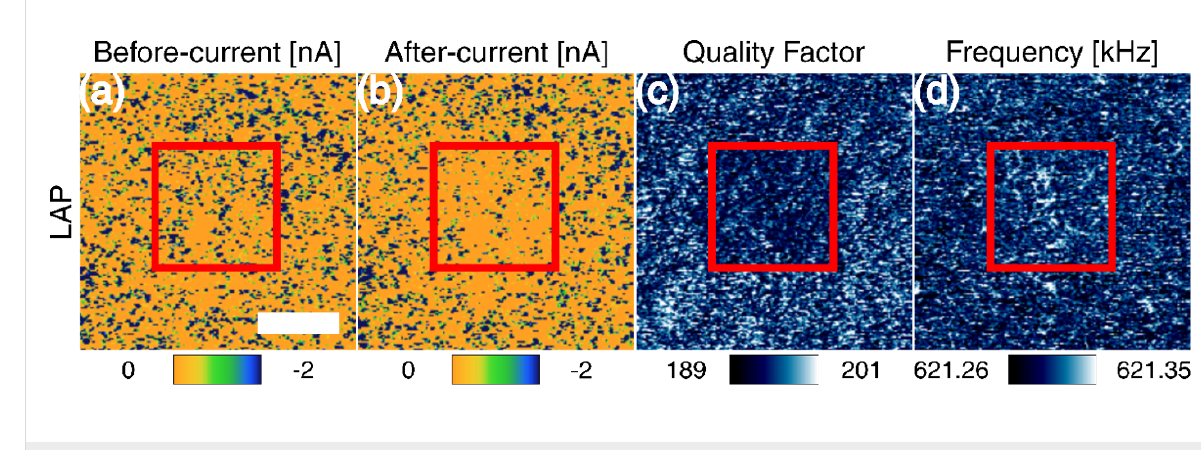
Figure 8: Electro-mechanical response of the transparent (thin) Laponite RD nanocomposite to the high-pressure treatment. Sequential imaging is used to acquire (a) current before the bimodal AFM treatment, (b) current after the treatment and, finally, (c,d) mechanical parameters after the treat- ment ((c) quality factor and (d) frequency), where the images have been automatically correlated. The bimodal-AFM-treated area is enclosed by the red square. The scale bar is 1 μ m.